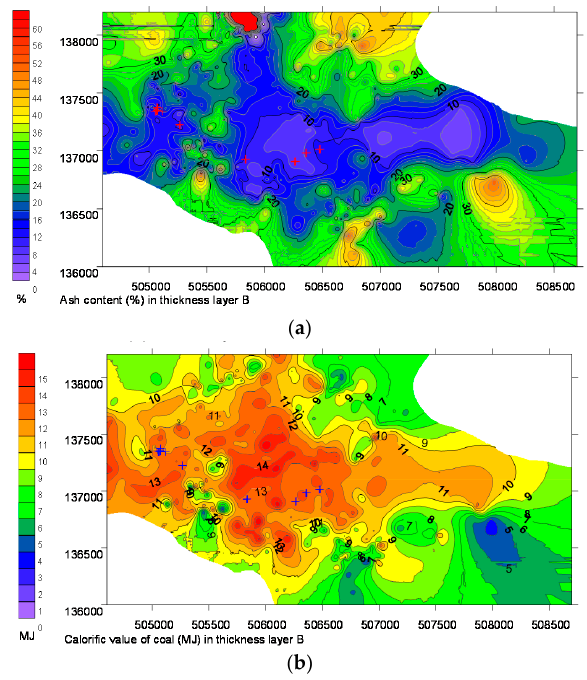
Figure 10. ( a ) Ash content of coal and locations of coal bursts source in thickness layer B; and ( b ) Calorific value of coal and coal burst source locations in thickness layer B.